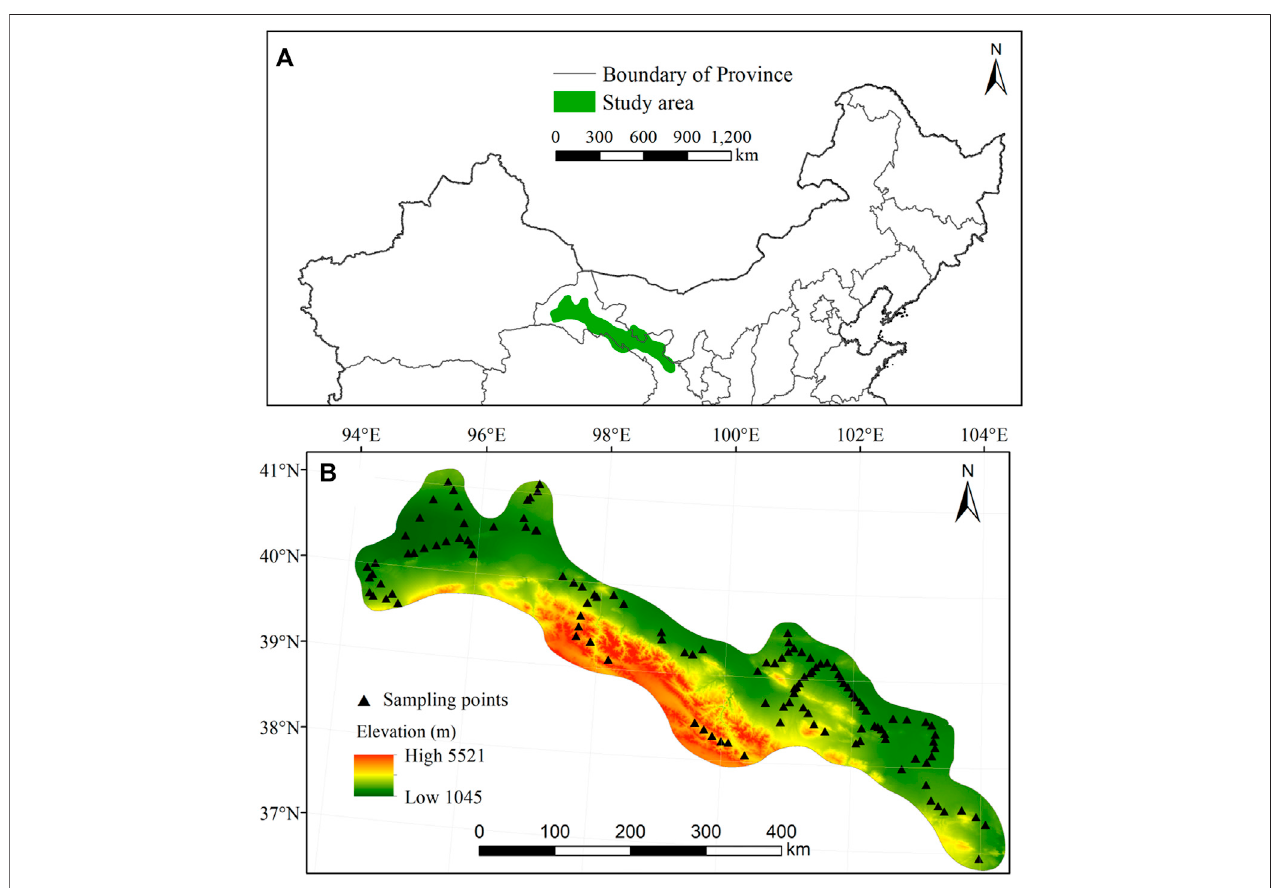
FIGURE 2 | Locations of the study area and the 126 sampling sites, which are superimposed on a digital elevation model with 500 m resolution.